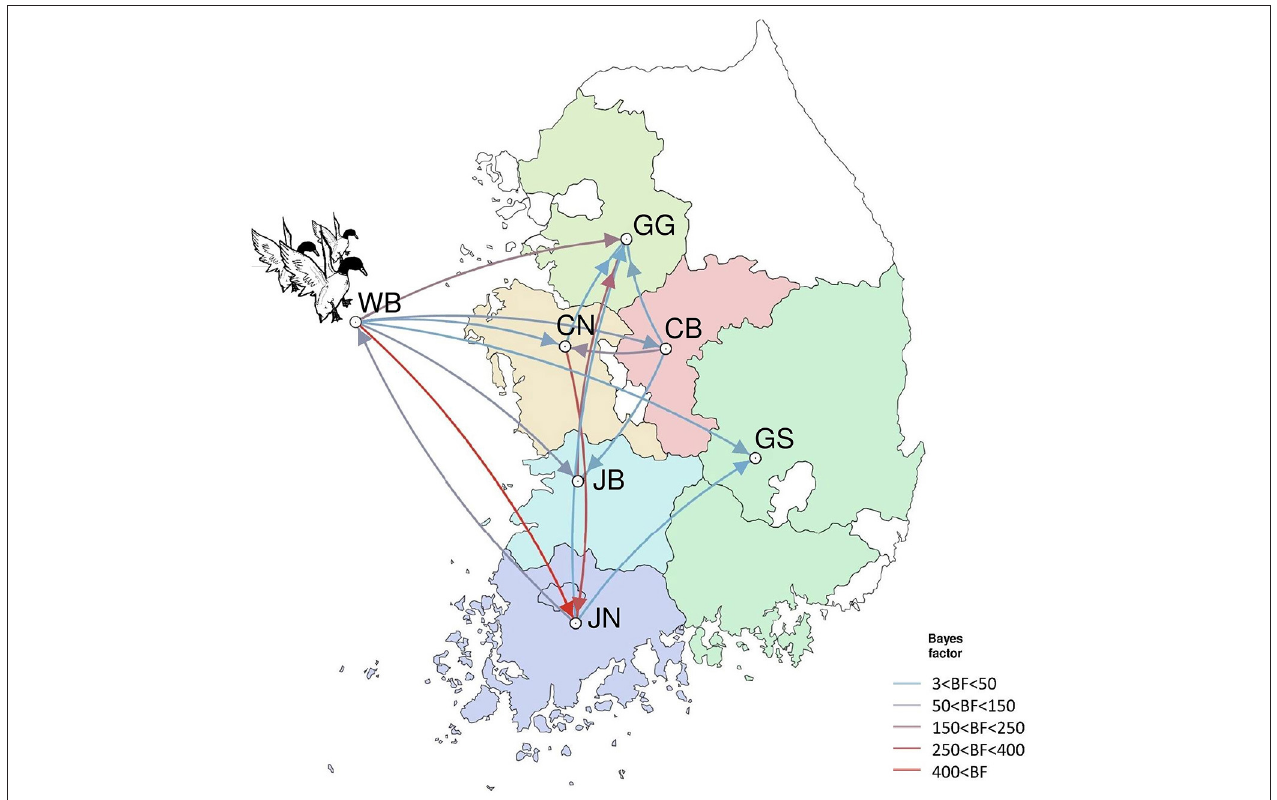
FIGURE 10 | Inferred transmission networks of H5N8 viruses between regions. Arrows show the directions of transmission. Line colors indicate the overall Bayes Factor test support for epidemiological linkage. WB, wild bird; JB, Jeollabuk-do; JN, Jeollanam-do; GG, Gyeonggi-do; GS, Gyeongsang-do; CN, Chungcheongnam-do; CB, Chungcheongbuk-do.